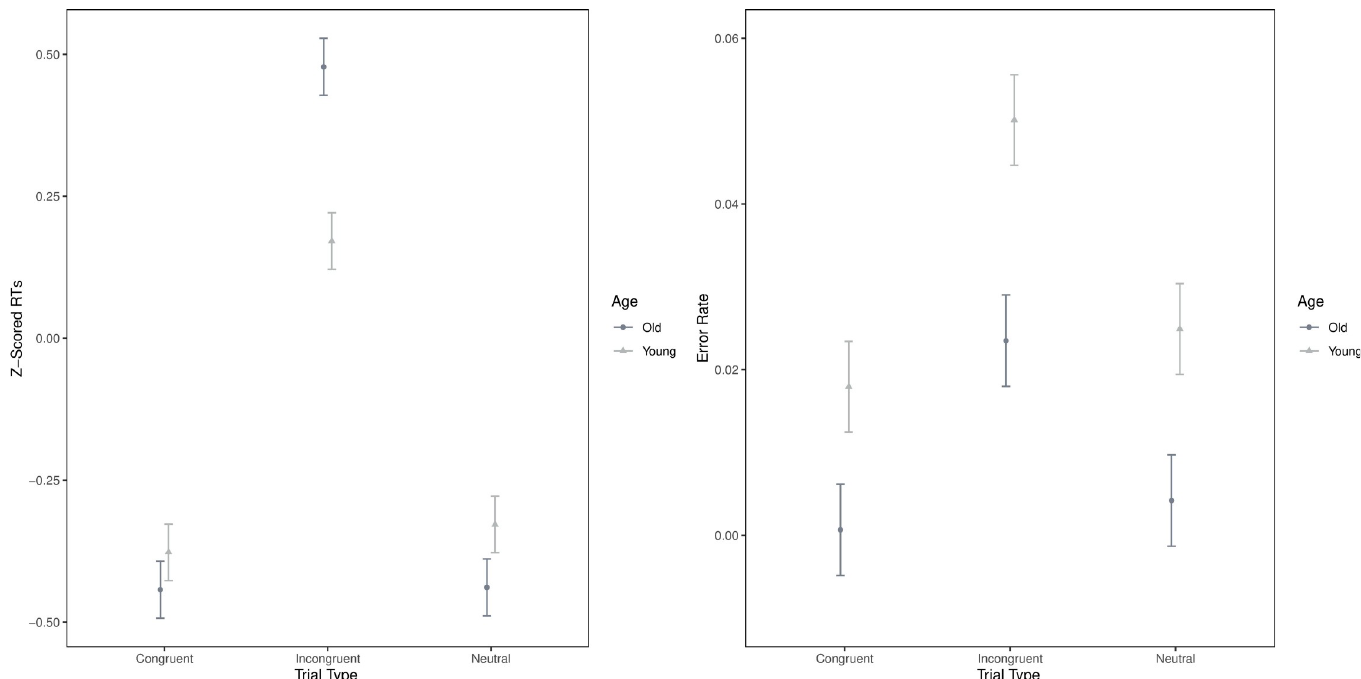
Fig 2. A. Z-scored response times for trial type and age. B. Error rates for trial type and age.